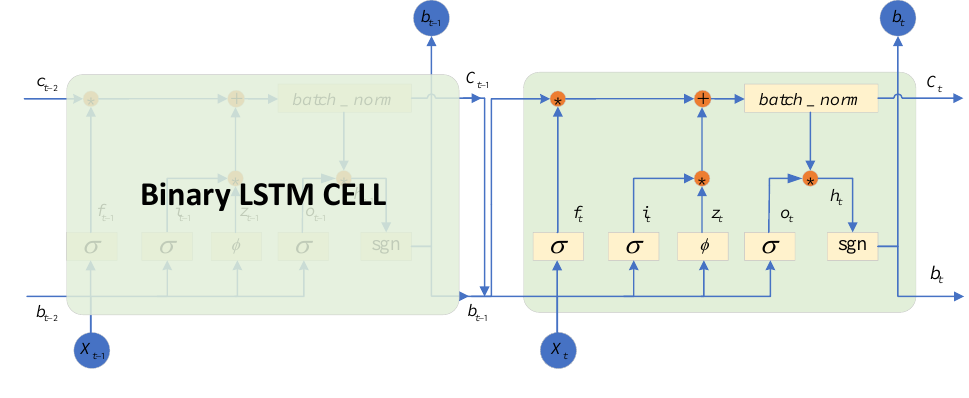
Figure 5. Binary